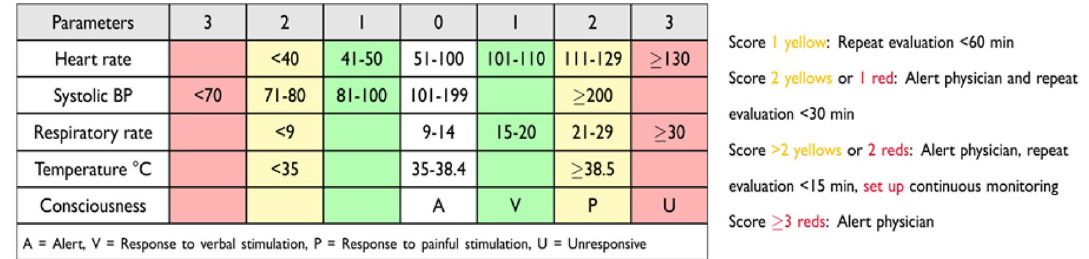
Figure 1. Table for assignment of patient priority code at the ER triage.